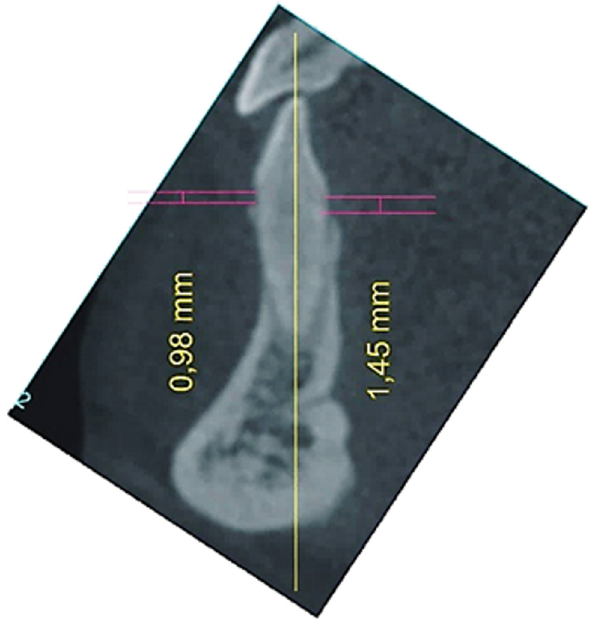
Figure 2: Screenshot of the CorelDraw 9 software with measure - ments CEJ – BBC and CEJ –